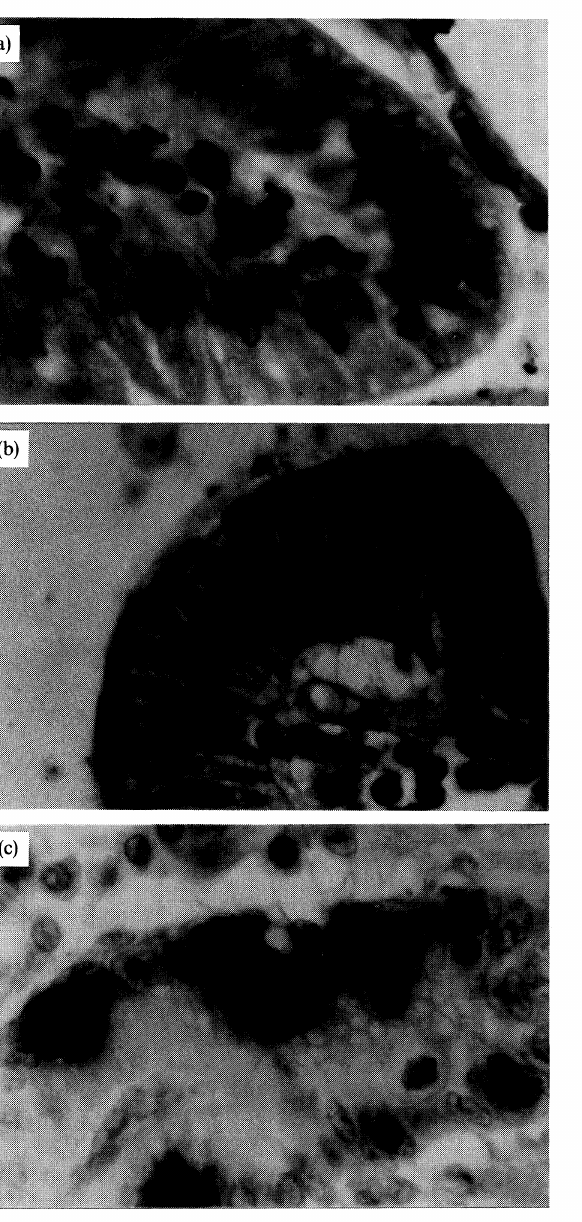
FIG. 1. (a) Villus enterocytes showing low level uptake of BrdU after exposure to TNF(x in culture (xl 900). The replication points are largely confined to the nuclear membrane. The BrdU uptake is most obvious in enterocytes at the extreme tip of the villus. (b) Villus tip enterocytes from the control culture showing negligible BrdU uptake (xl 900). (c) Crypt enterocytes showing high level BrdU uptake during S phase after a similar culture period in normal medium. All sections were visualized with the same immunoperoxidase/DAB staining protocol. Mediators of Inflammation. Vol 4.